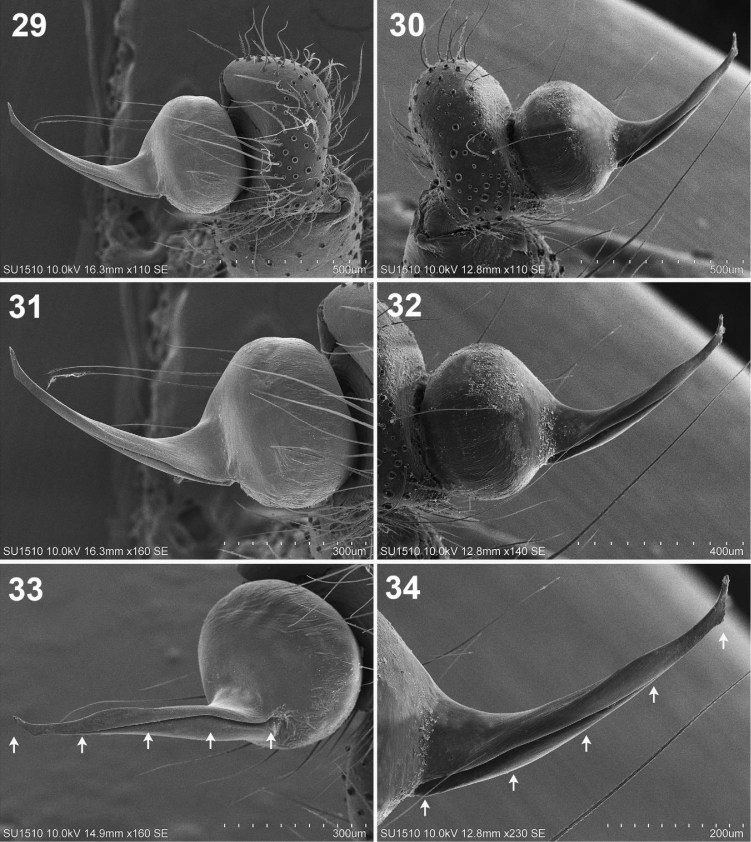
29–31Loxosceles
misteca Gertsch. Male 29 left palp, retrolateral view, detail of tarsus, bulb and embolus 30 detail of bulb and embolus, retrolateral view 31 detail of the embolus 32–34Loxosceles
tenochtitlan sp. nov. Male paratype 32 right palp, retrolateral view, detail of tarsus, bulb and embolus 33 detail of bulb and embolus, retrolateral view 34 detail of the embolus. Arrows indicate the canal along the embolus.